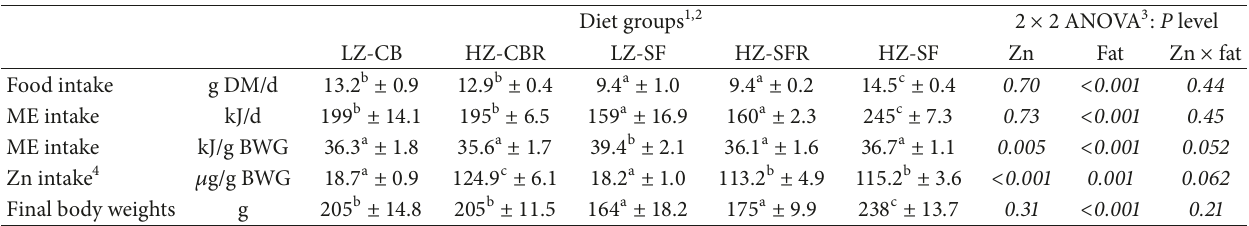
Table 2: Food and ME Zn intake and final body weights of male weanling rats fed high-fat diets differing in Zn content and fat source free choice or in restricted amounts for